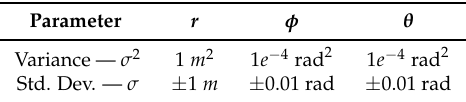
Table 2. Minimum variances and standard deviations of measurement noises used in simulation